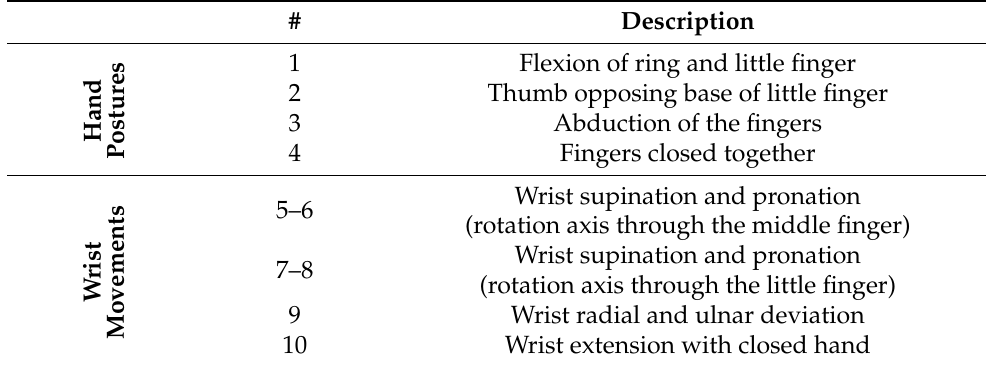
Table 1. Synthetic descriptions of 10